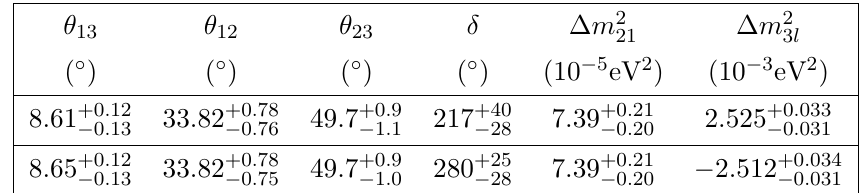
Table 1 . Best (cid:12)t value and 1 (cid:27) ranges of the neutrino oscillation parameters from a global (cid:12)t to neutrino data [22]. Upper (lower) values are for neutrino mass spectrum with normal (inverted) ordering, for which (cid:1) m 2 (cid:1) m 2 ((cid:1) m 2 (cid:1) m 2 31 32 3 l (cid:17) 3 l (cid:17)